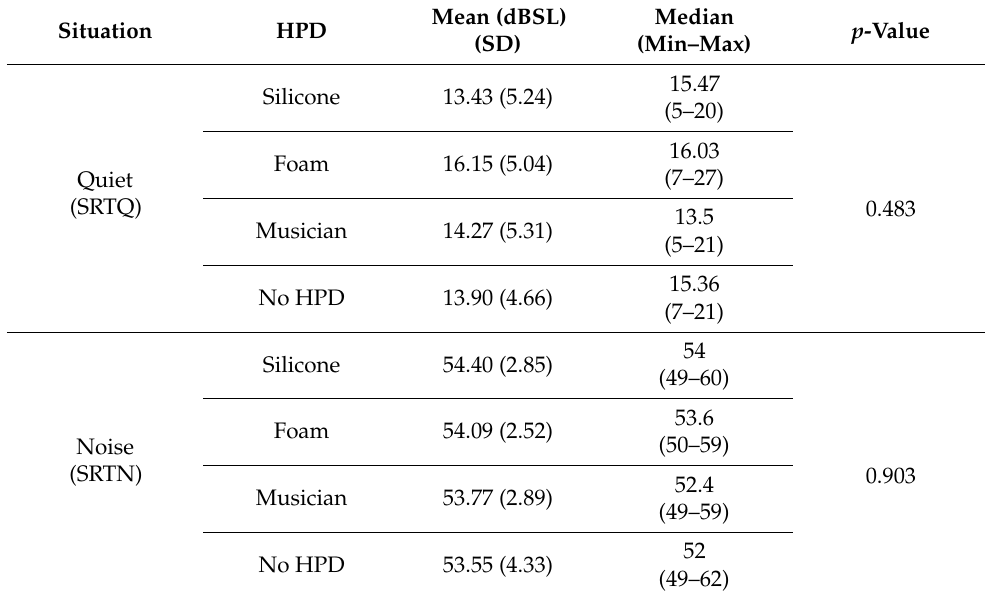
Table A2. Sentence recognition thresholds in quiet and in noise with and without